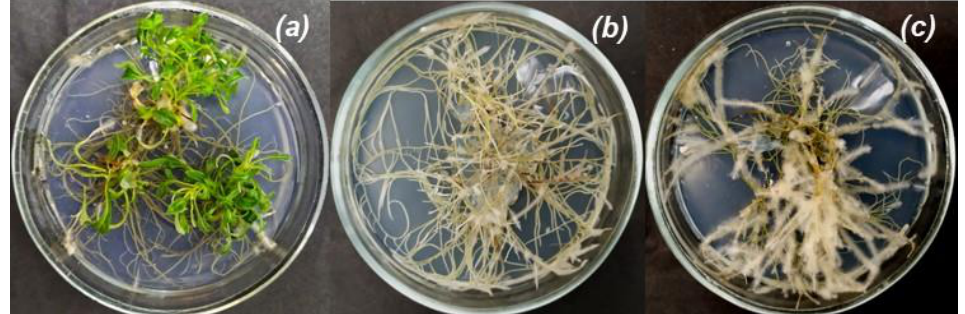
Figure 1. Artemisia tilesii control plants grown in vitro ( a ) and various lines of “hairy” root culture ( b —№ 4, c —№ 3).